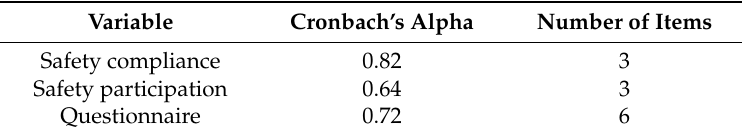
Table 6. Safety behavior scale reliability